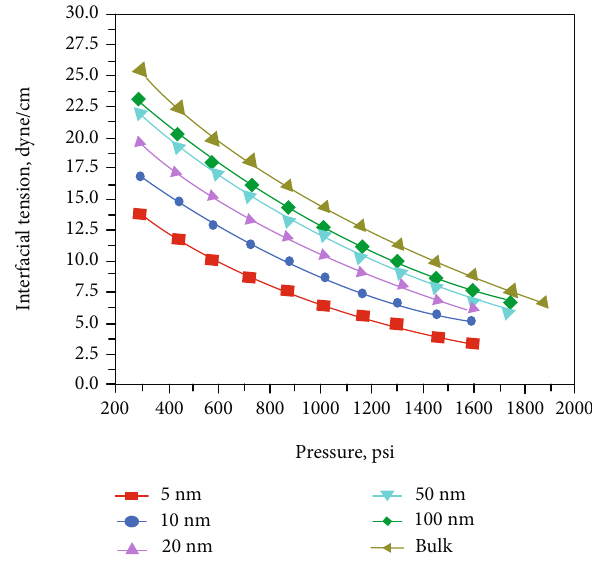
Figure 6: Interfacial tension of the Bakken tight oil versus pressure at various pore radii at T = 230 ° F.